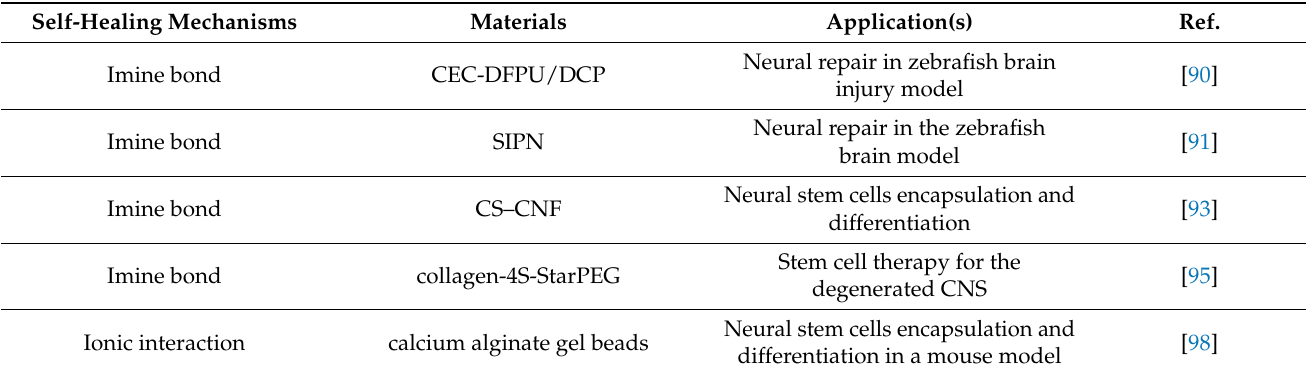
Table 5. A summary of self-healing hydrogels used in vitro and in vivo for neural tissue engineering. Self-Healing